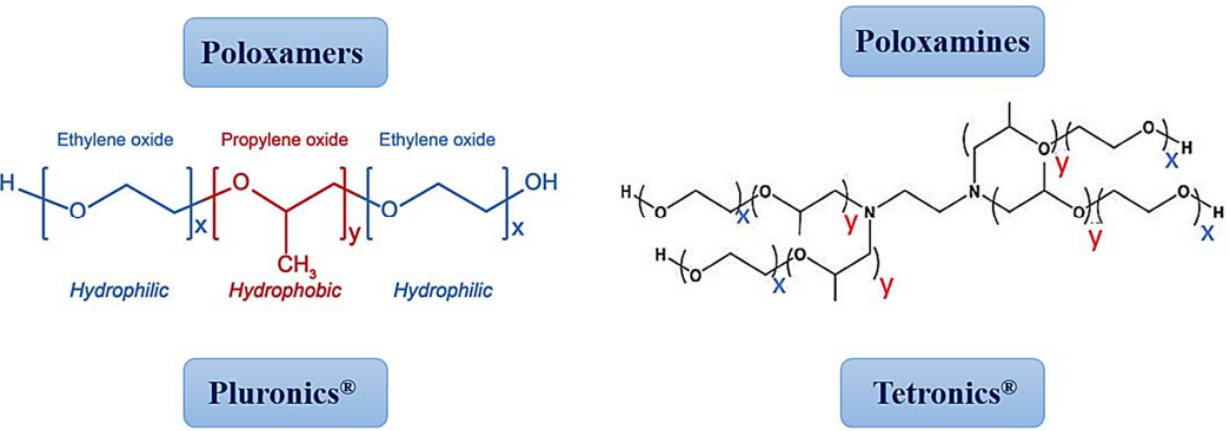
Figure 5. Structures of poloxamers/Pluronics ® and poloxamines/Tetronics ®